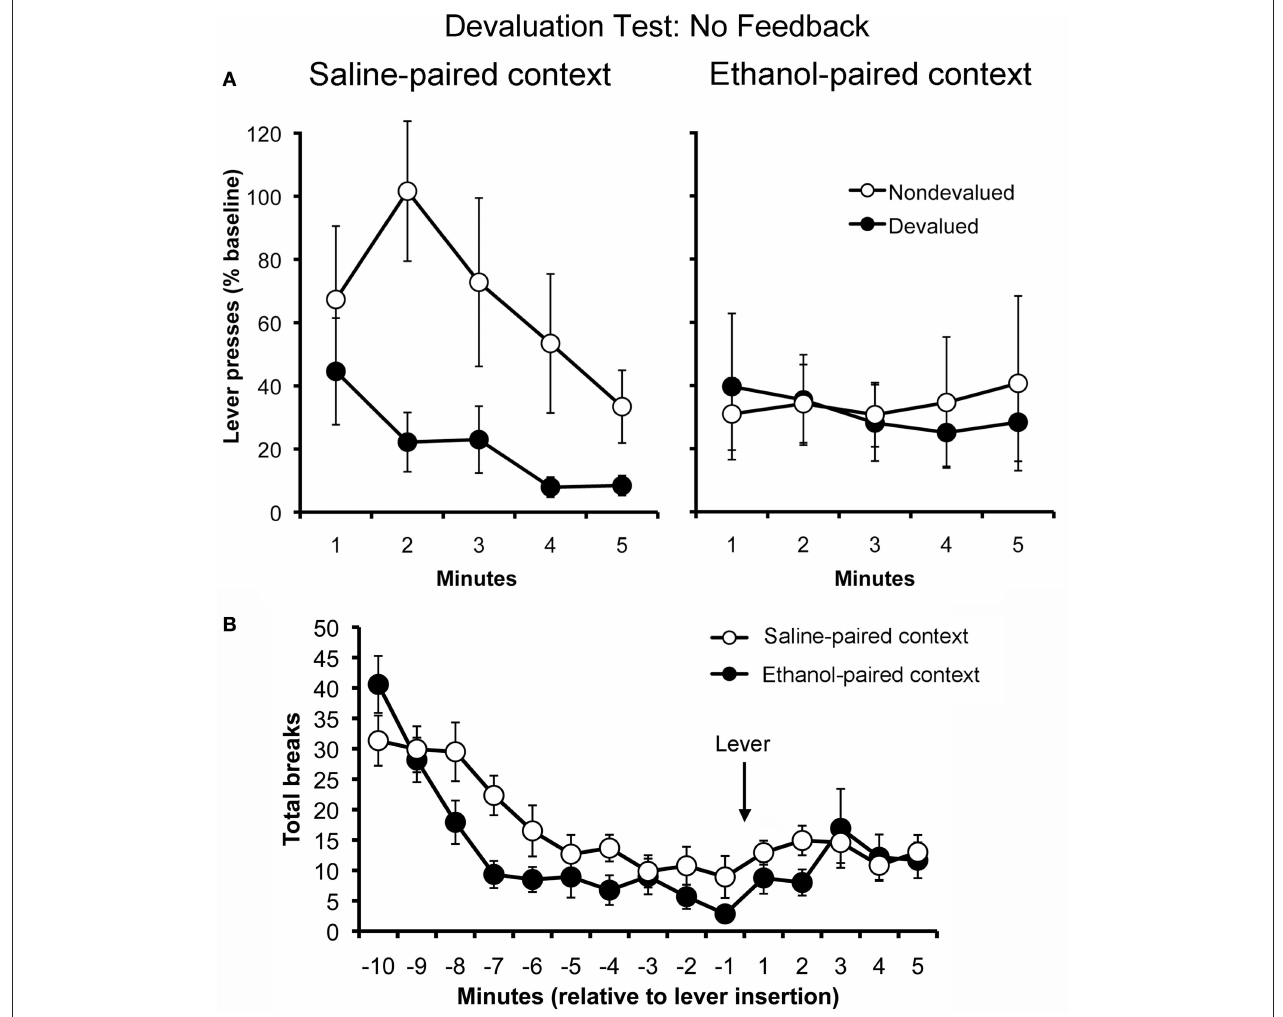
FIgure 2 | effect of ethanol-paired contextual cues on the control of instrumental performance in a test of outcome devaluation conducted in extinction (i.e., without response-contingent feedback) (experiment 1) . Mean rate of responding (expressed as a percentage of pre-test baseline responding, ± SEM) for the action trained with the devalued outcome and the